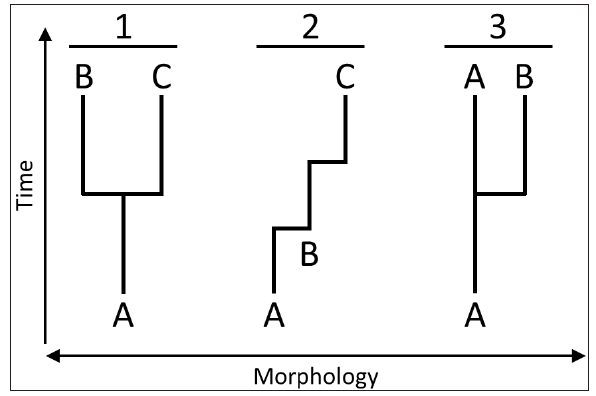
Figure 1: Modes of speciation: (1) bifurcating cladogenesis, (2) anage- nesis and (3) budding cladogenesis. In both Modes 1 and 2, ancestors cannot be contemporaneous with their descen- dants as the entire ancestral species evolves into one or more descendant species. In Mode 3, ancestral and descendant taxa can coexist as a, typically geographically isolated, population speciates from the main population, which retains its species